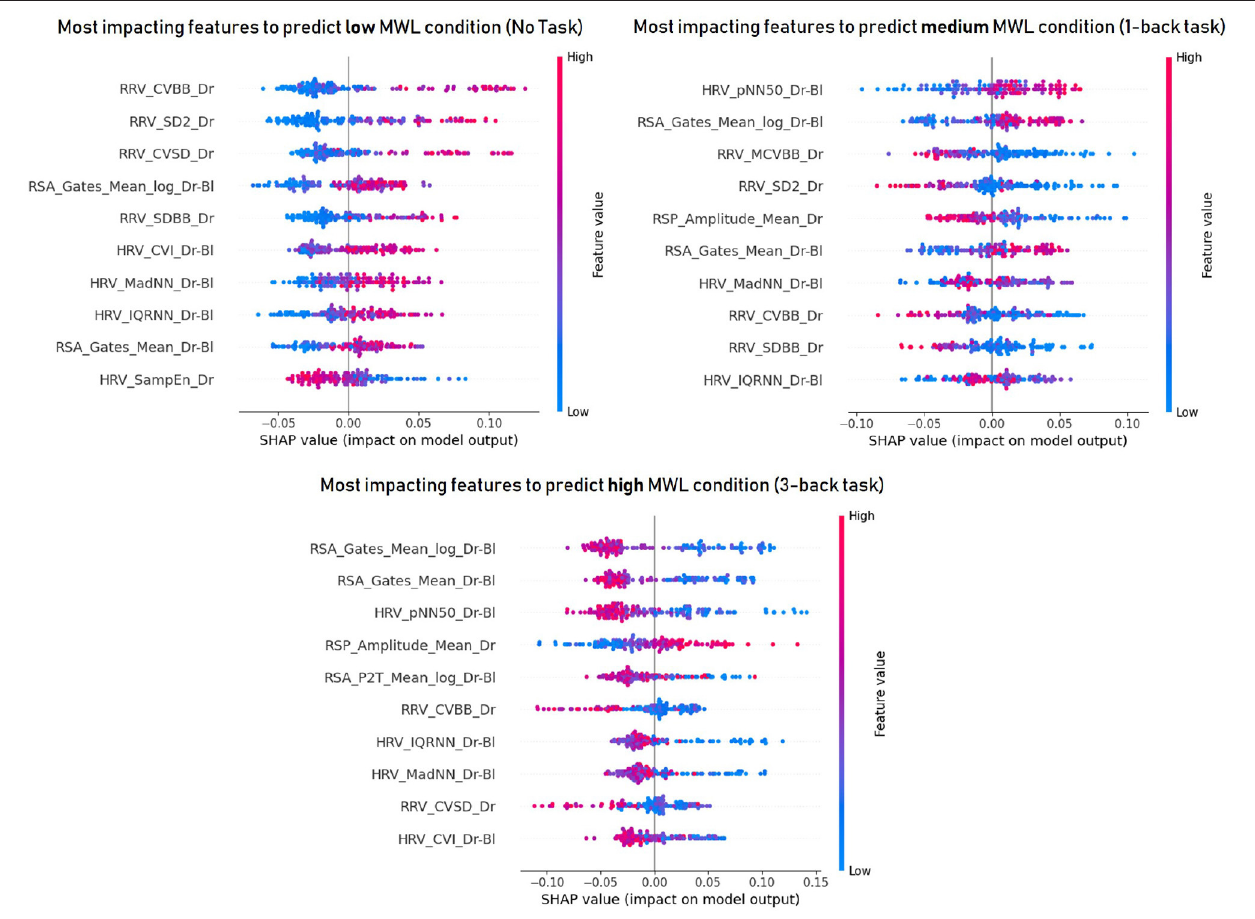
FIGURE 11 | The 10 most important features to predict drivers’ mental workload at each level : low (top left), medium (top right) and high (bottom) mental workload. The three signals (EDA + ECG + RESP) and a threshold for task performance of 100 were used. A high SHAP value (to the right on the x-axis) indicates that this feature influenced positively the model to predict that class. The meaning/description of each feature can be found in Table 2 . RRV, Respiratory rate variability; HRV, Heart Rate Variability; RSA, Respiratory Sinus